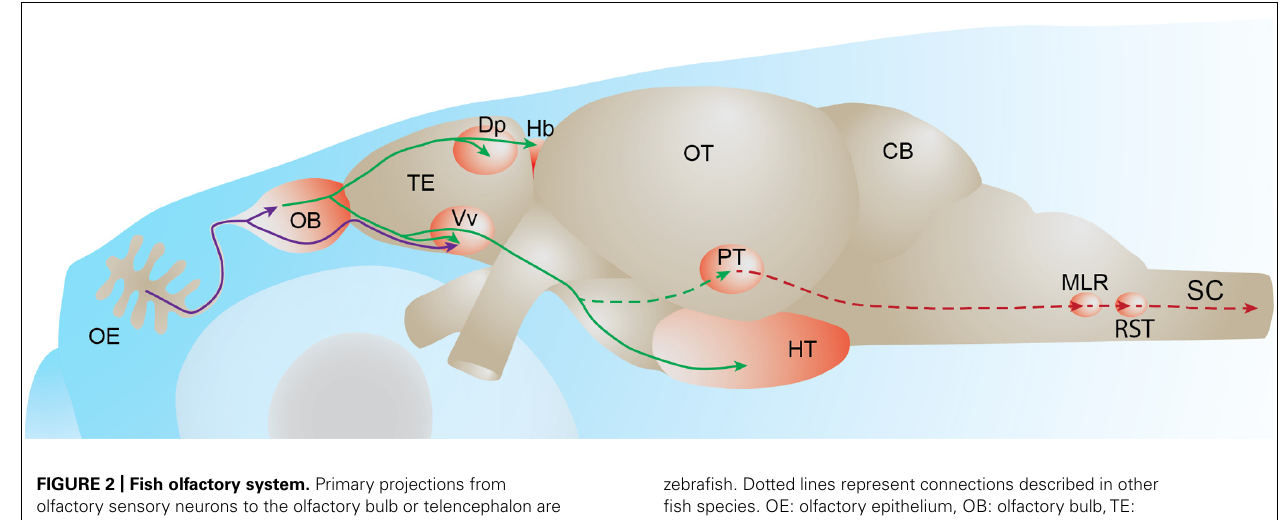
FIGURE 2 | Fish olfactory system. Primary projections from olfactory sensory neurons to the olfactory bulb or telencephalon are depicted in purple. Secondary olfactory projections from the olfactory bulb to the telencephalon and diencephalon are depicted in green. A putative olfacto-motor pathway connecting the posterior tubercle to executive motor centers in the mesencephalon, described in lampreys, is depicted in red. Solid lines represent connections described in